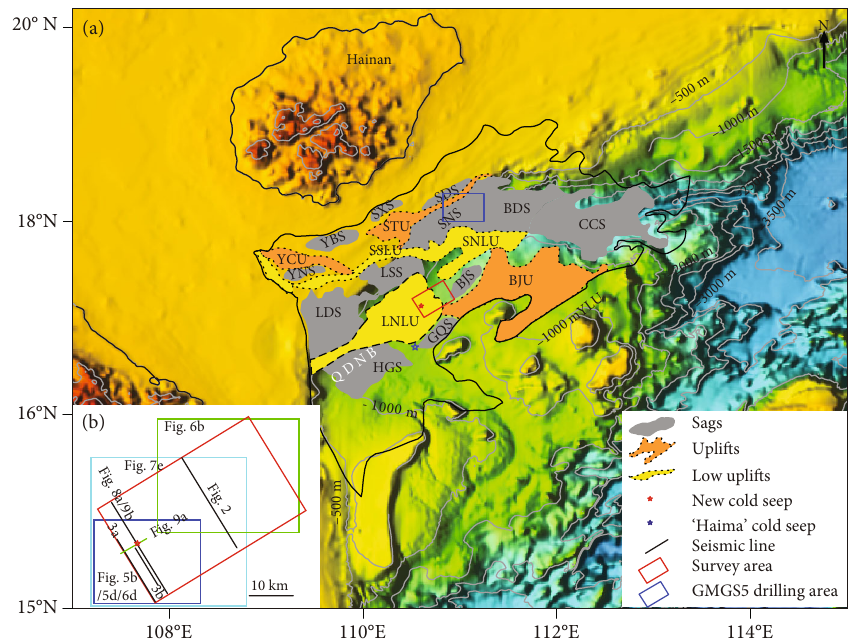
Figure 1: (a) The study area in the QDNB and (b) its corresponding ampli fi ed map. The black lines in panel (a) mark the boundary of the QDNB. The gray, orange, and yellow areas indicate sags, uplifts, and low uplifts in the basin, respectively. The red and blue rectangles show the study area and the GMGS5 drilling area, respectively. The red and blue stars label the newly discovered and “ Haima ” cold seeps, respectively. The black and green lines in panel (b) mark the seismic lines and echogram, respectively. The blue, cyan, and green areas indicate the locations of Figures 5(b), 5(d), and 6(d), Figure 7(e), and Figure 6(b), respectively. BJS: Beijiao Sag; BDS: Baodao Sag;